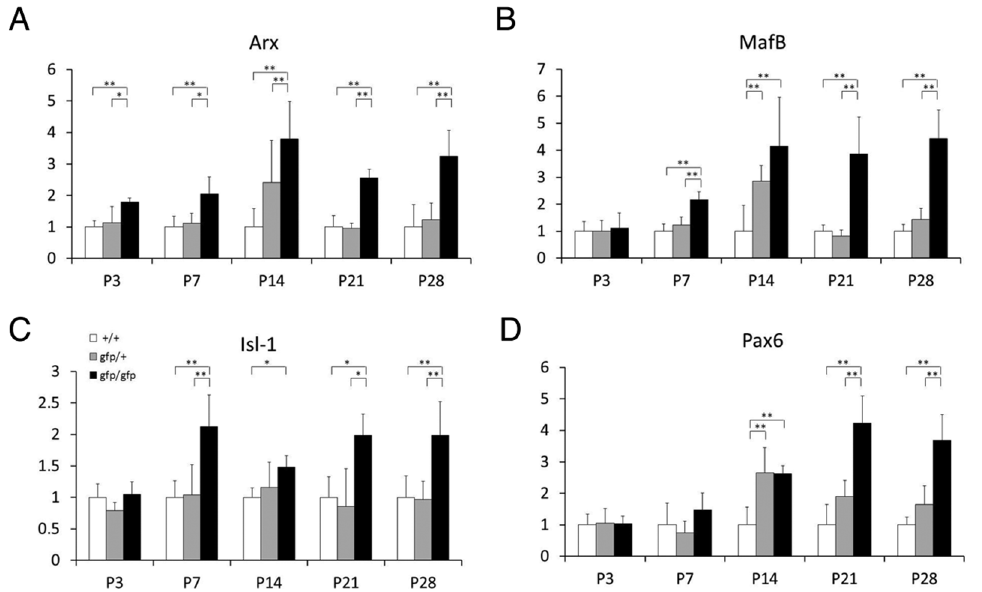
Figure 1. Ontogenetic expression of transcription factors in Gcg gfp/gfp mice. Relative expression levels of Arx (A), MafB (B), Isl-1 (C), and Pax6 (D) from P3 to P28 are shown as mean 6 SEM (N=5). Open bars, wild-type mice ( Gcg + / + ); shaded bars, heterozygous mice ( Gcg gfp/ + ); closed bars, homozygous mice ( Gcg gfp/gfp ). *: P , 0.05, **: P , 0.01.